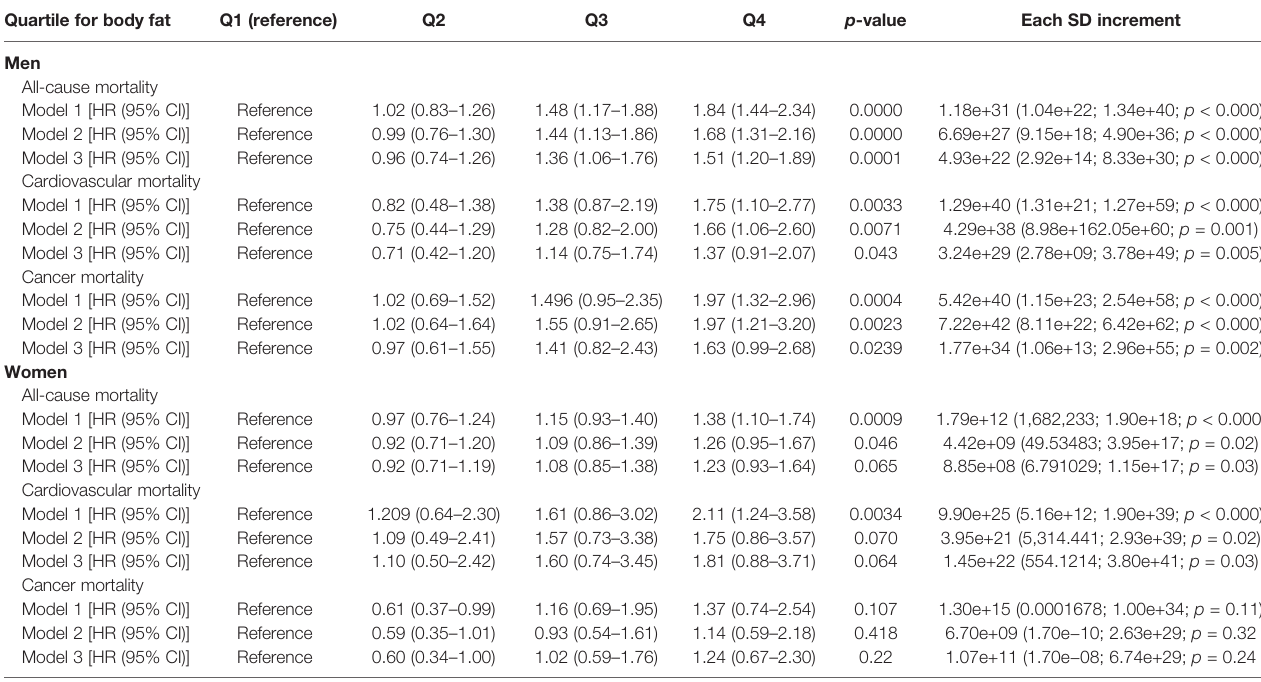
Model 1: adjusted for age and race/ethnicity. Model 2: additionally adjusted for annual household income, education, diabetes, hypertension, stroke, and coronary artery disease. Model 3: Model 2 plus